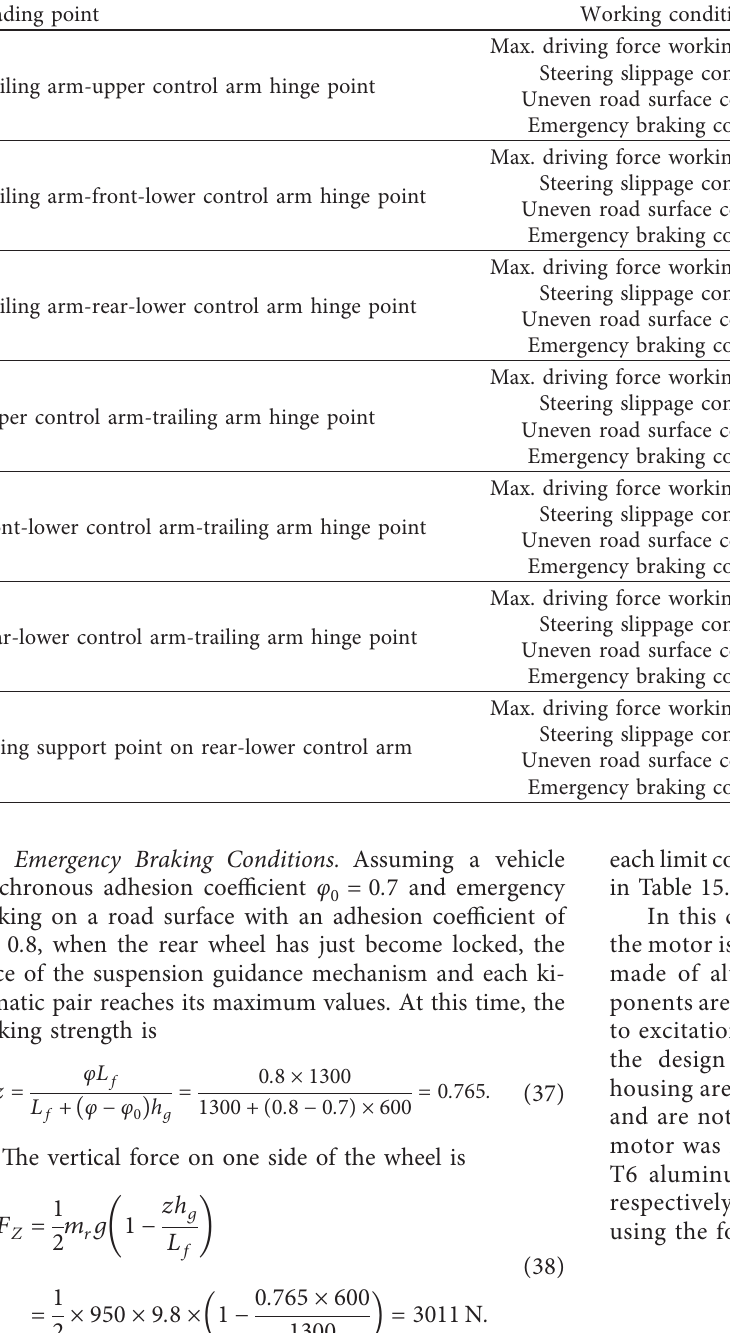
Table 15: Forces at each node under different working